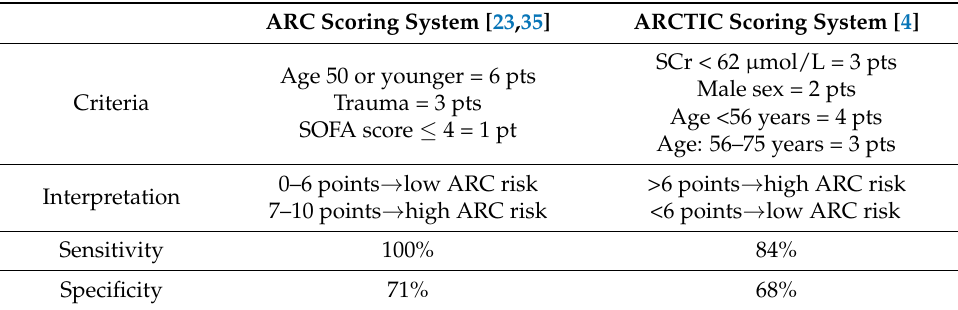
Table 2. The ARC risk scoring